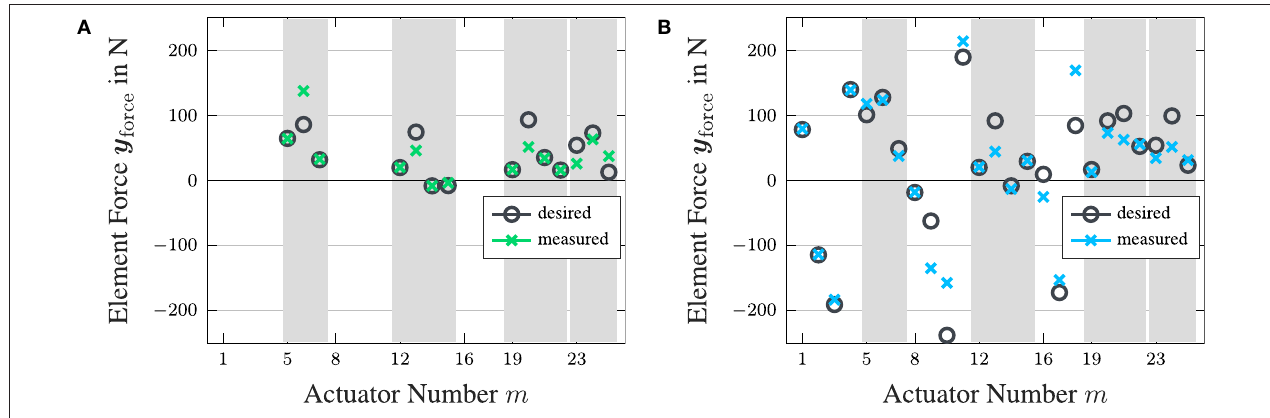
FIGURE 8 | Measured element forces of the actuated elements (crosses) and the desired element forces (circles). Serial actuators are marked by a gray background. Element forces of the structure under load (A) without compensation and (B) with compensation. The data is summarized in Table A2 in the Appendix.